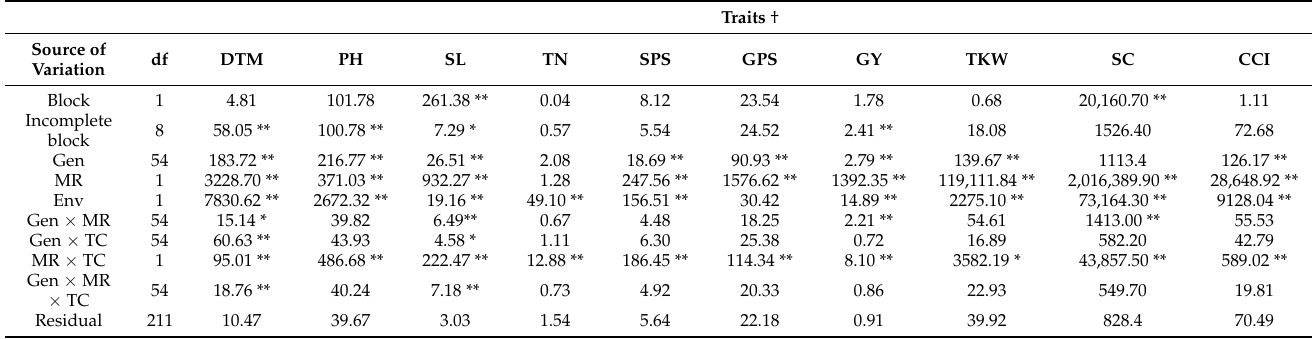
Table 1. Analysis of variance showing mean squares and significant tests for assessed agronomic and physiological traits among 10 wheat parents and their F 1 progenies under irrigated (WW) and terminal drought (TD) in rainout shelter (RS) and greenhouse (GH)